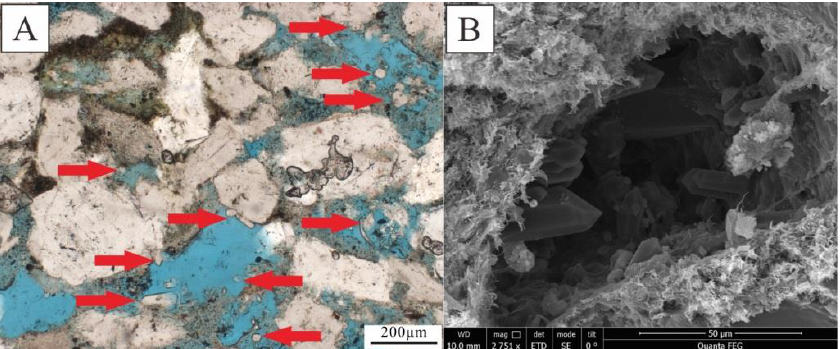
Figure 9. The quartz crystals in pores. (A) Quartz crystals filling in pores of a sandstone in thin section, under plane-polarizing light, indicated by the red arrow. (B) Quartz crystals in the pores of a sandstone under SEM.